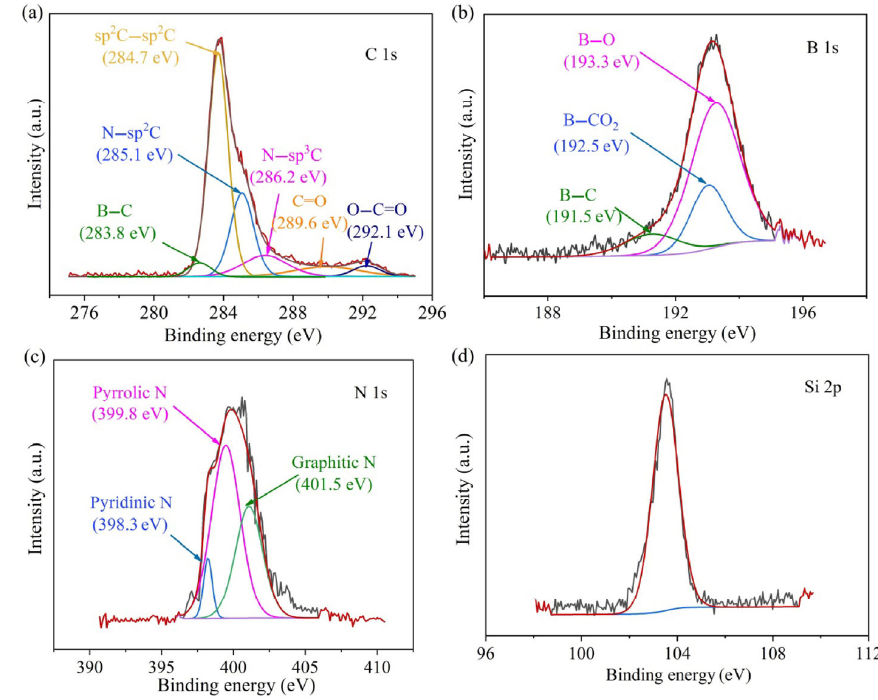
Fig. 5 XPS spectra of the SiO 2 –B–N–GO nanoparticles: (a) C 1s, (b) B 1s, (c) N 1s, and (d) Si